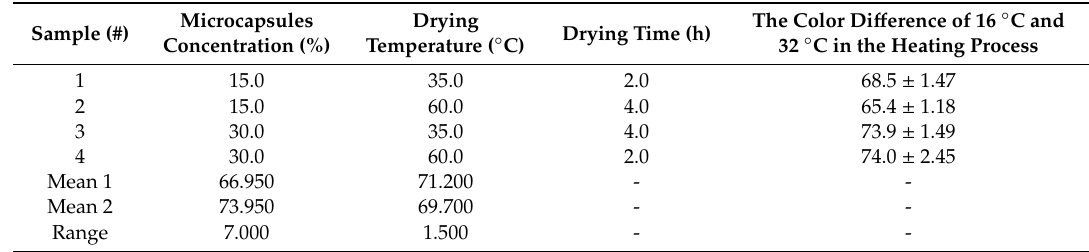
Table 3. Analysis results of the orthogonal experiment.